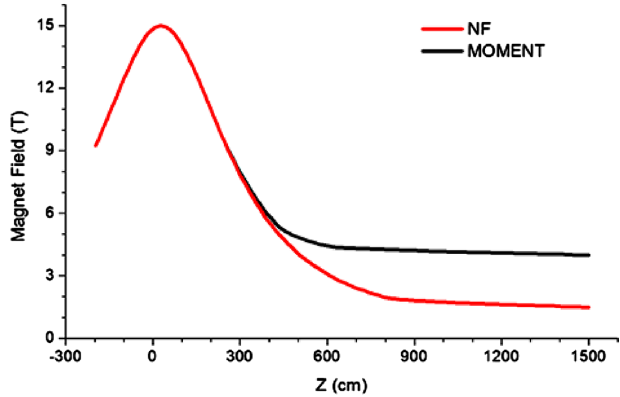
FIG. 6. Medium density (relative factor) distributions (in x-y plane) for the grain waterfalls with 2, 3, and 4 cm target width.